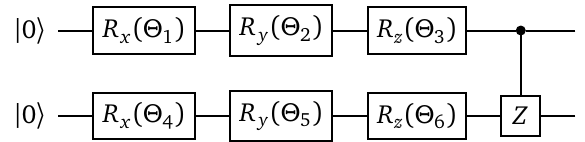
Figure 7: Circuit for two qubits that generate one set of U